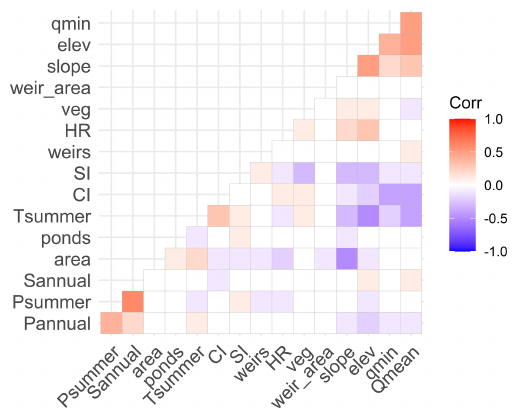
Figure B3. Correlation matrix of all 16 considered environmental variables prior to selection in the thermal peak analysis. All vari- ables had collinearity values less than 0.6 or greater than −